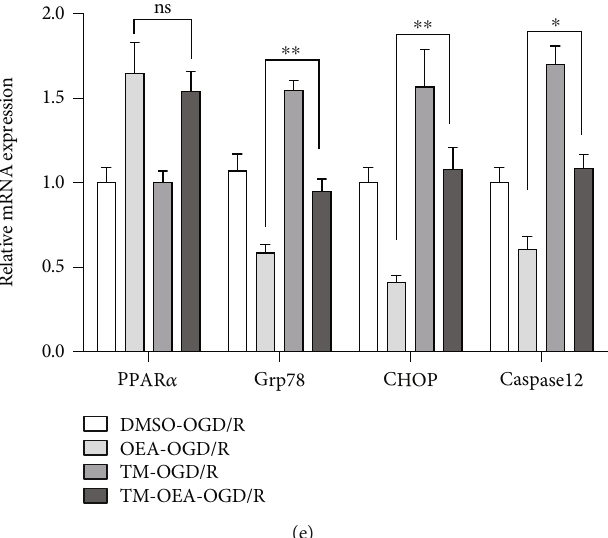
Figure 4: OEA induced-PPAR α activation attenuates ER stress-associated apoptosis. TM treatment of HepG2 cells (1 μ g/ml) was conducted for 6h, and OEA treatment (20 μ M) was conducted for 1h before OGD/R. The proteins were harvested at 6h after reoxygenation. (a and b) Western blotting analysis of PPAR α , Grp78, CHOP, Caspase12, and cleaved-Caspase3 expression. (c and d) HepG2 cells were treated with TM for 6h or OEA for 1 h before OGD/R operation. Western blotting analysis of PPAR α , Grp78, CHOP, Caspase12, and cleaved-Caspase3 expression. (e) The relative mRNA expression of PPAR α , Grp78, CHOP, and Caspase12. ∗∗ p < 0 : 01 and ∗ p < 0 : 05